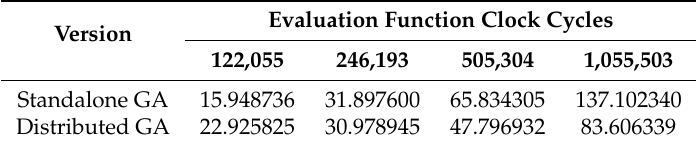
Table 11. Processing time (in seconds) for standalone (1 node) and distributed GA (2 nodes), both running at 16 MHz.